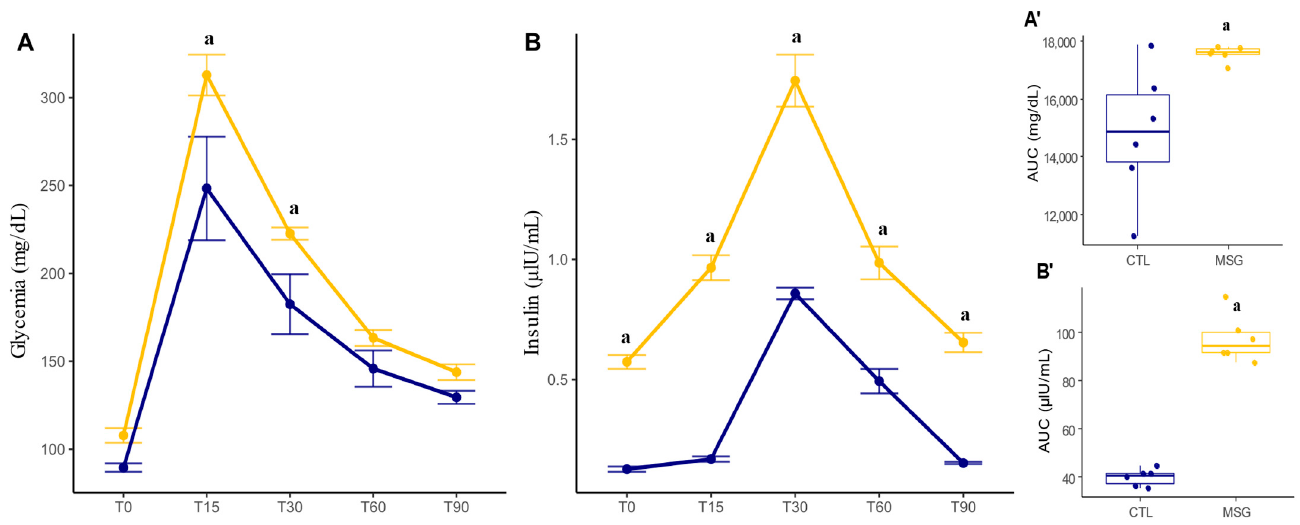
Figure 3. Graphs related to ipGTT and insulin dosage of CTL and MSG animals at 135 days of life. ( A ): Graph of blood glucose during the test (mg/dL); ( B ): insulin level graph (µIU/mL); ( A’ ): AUC of blood glucose during the test (mg/dL); ( B’ ): AUC of insulin level (µIU/mL). The CTL is represented in blue and the MSG group is represented in yellow. The letter a represents the difference between the MSG group when compared to the CTL. ( A , B ): repeated measurements ANOVA. ( A’ , B’ ): Student’s t -test.